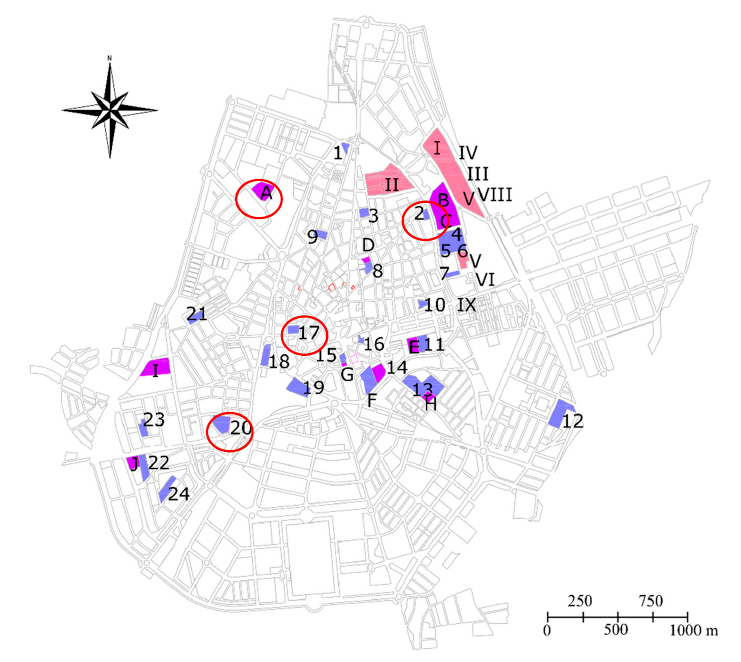
Figure A1. School Distribution in Ciudad Real. Table A1. School-age population and schools in urban zones relation.